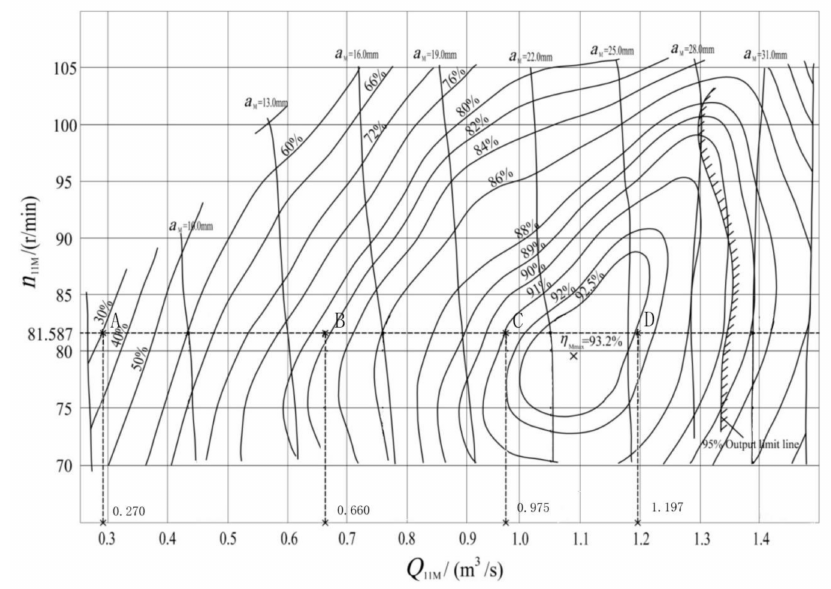
Figure 4. A551-35 model comprehensive characteristic curve.